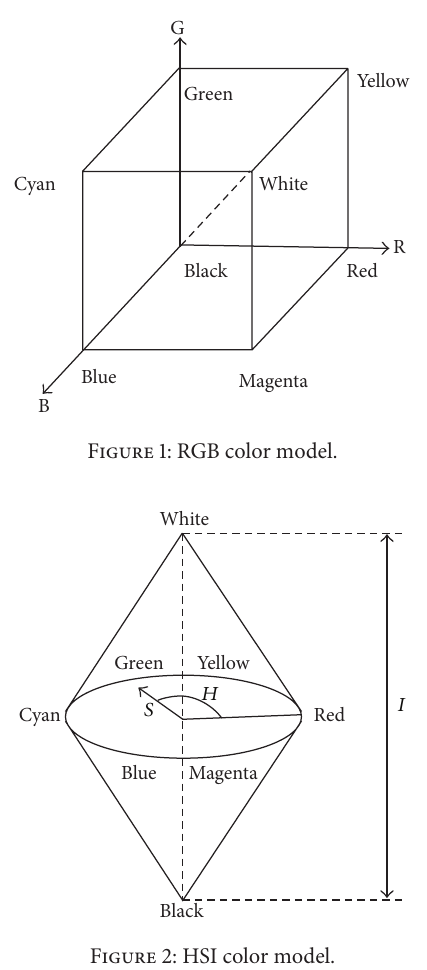
Figure 2: HSI color